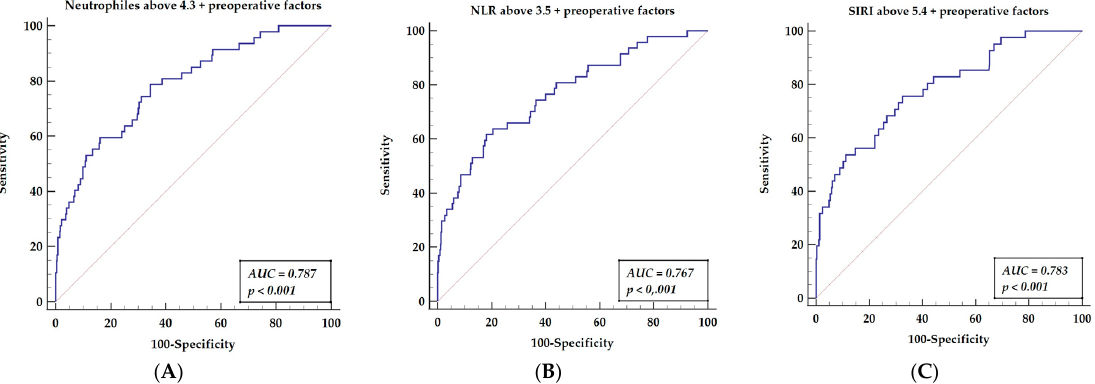
Figure 3. Receiver operator characteristics curves of three hematologic indices related to neutrophils (neutrophil counts ( A ), NLR ( B ), SIRI ( C )), paired with preoperative factors that are significant for mortality prediction in multivariable analysis. Abbreviations: NLR—neutrophil-to-lymphocyte ratio, SIRI—systemic inflammatory response index. Preoperative factors = stroke, peripheral artery disease, COPD, and PLR.